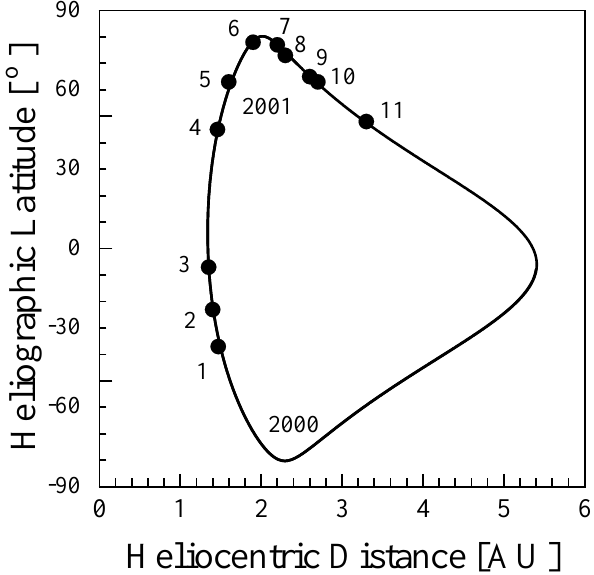
Fig. 1. The orbit of the spacecraft Ulysses. The second fast latitude scan from south to north during the solar maximum mission lasts from November 2000 to October 2001 (events 1–6). The circles represent the averaged helio-latitude and heliocentric distance of the spacecraft during the eleven selected time